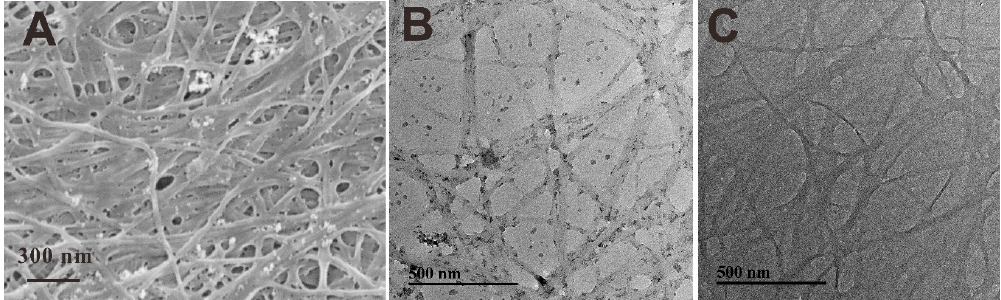
Figure 3. SEM image ( A ) of PdBC. TEM images of: PdBC ( B ); and BC ( C ).